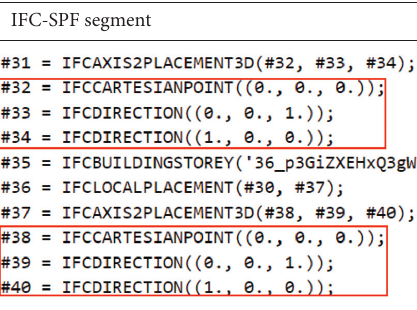
Figure 3: Simple data redundancy in